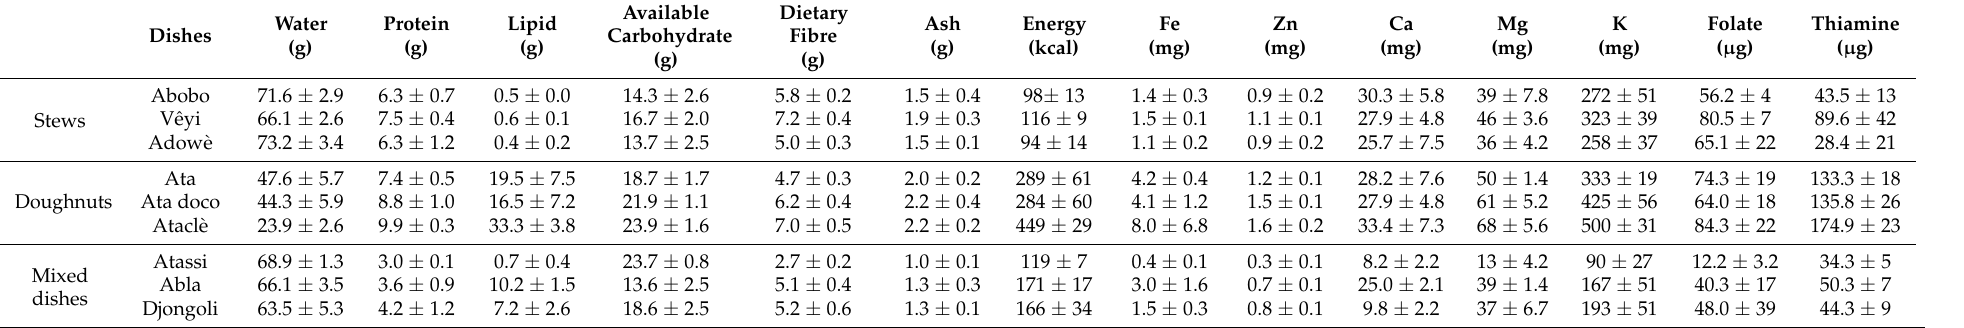
Table 4. Nutritional composition of the nine cowpea-based dishes (per 100 g of edible